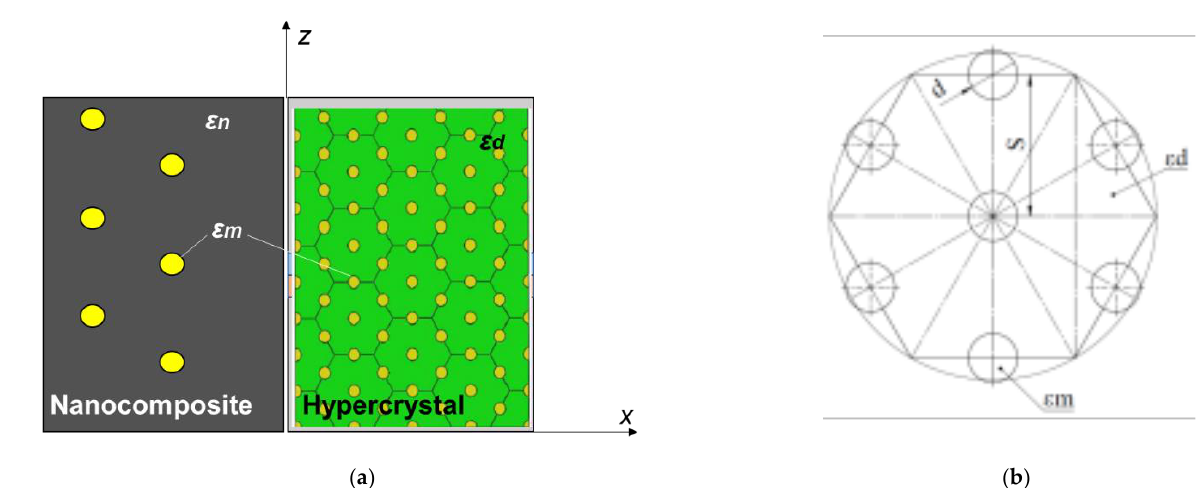
Figure 1. Schematic system under consideration, involving a semi-infinite hypercrystal ( x > 0) and a nanocomposite with semiconductor inclusions ( x < 0) ( a ) and metamaterial (hypercrystal) unit cell ( b ).